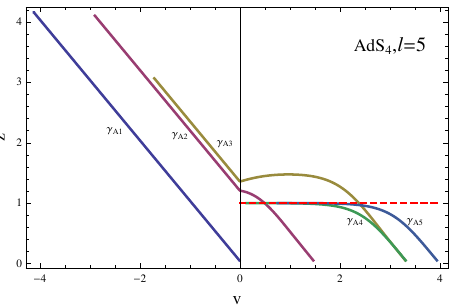
Figure 9 . The snaps of the evolution of entanglement surface (cid:13) A in the ( v; z ) plane. The time (cid:13)ows from left to right. (cid:13) A i ( i = 1 ; 2 ; 3 ; 4 ; 5) are the entanglement surfaces corresponding to the boundary times t = (cid:0) 0 : 01 ; 1 : 4660 ; 3 : 3248 ; 3 : 3248 and 3 : 9373, respectively. (cid:13) A 3 and (cid:13) A 4 have the same area at boundary time t = 3 : 3248, which corresponds to the transition point. The red dashed line is the apparent horizon. We (cid:12)x M = 1 ; v 0 = 0 : 01 here.